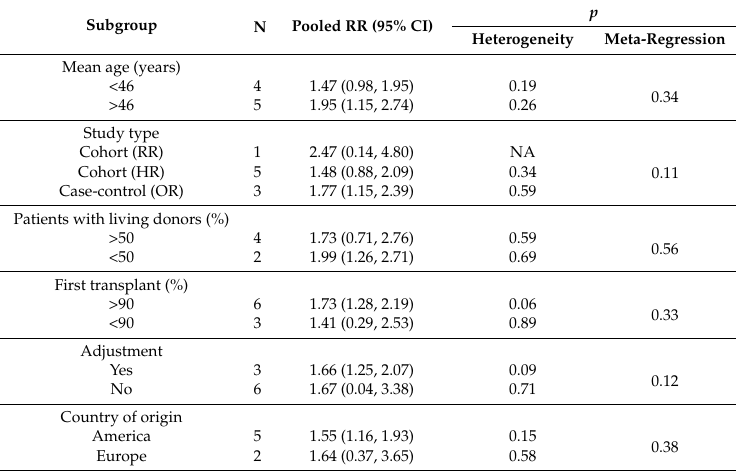
Figure 2. Forest plot on the association between AT1R-Abs and AR. For each study, the estimation of RR and its 95% confidence interval (CI) are plotted with a box and a horizontal line. The pooled odds ratio is represented by a diamond. The area of the gray squares reflects the weight of the study in the meta-analysis. Table 2. Stratified analysis of the association between AT1R-Abs and AR